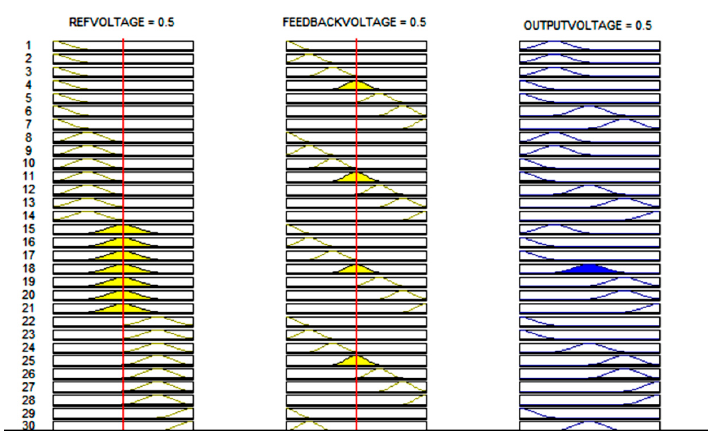
Figure 21. Rule viewer plot for Rule 3.